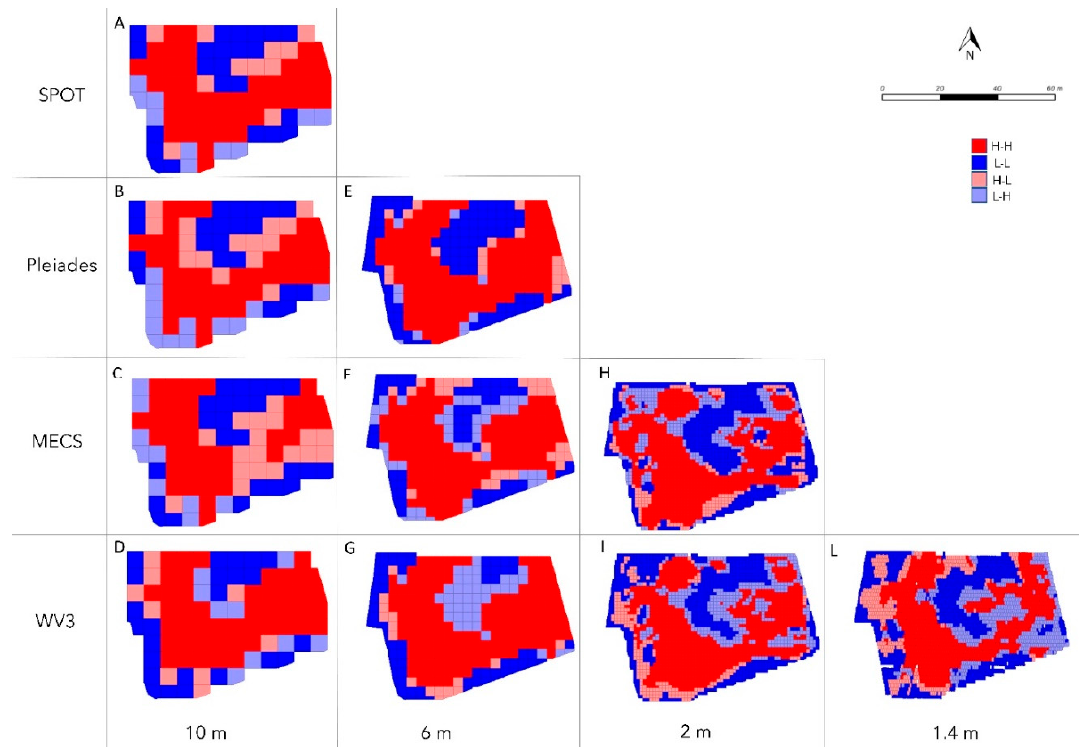
Figure 4. BILISA cluster map based on the Moran bivariate Index. The images were resampled as it follows: Spot-6, 10 m ground resolution; Pleiades, 6 m and 10 m ground resolution; MECS-VINE ® , 2 m, 6 m, and 10 m ground resolution; WorldView-3, 1.4 m, 2 m, 6 m, and 10 m ground resolution. Comparisons were performed by considering as the independent variable the vigor index value (NDVI or CI) derived from the native resolution acquisition (10 m: Sentinel-2; 6 m: Spot-6; 2 m: Pleiades; 1.4 m: MECS-VINE ® ), while the values of the resampled images were assumed as the dependent variable. The anal- ysis was conducted using a queen contiguity approach with the first-order of neighbors for each acquisition. Different colors correspond to four types of local spatial autocorrelation (red = High-High; dark blue = Low-Low; light red = High-Low; light blue =